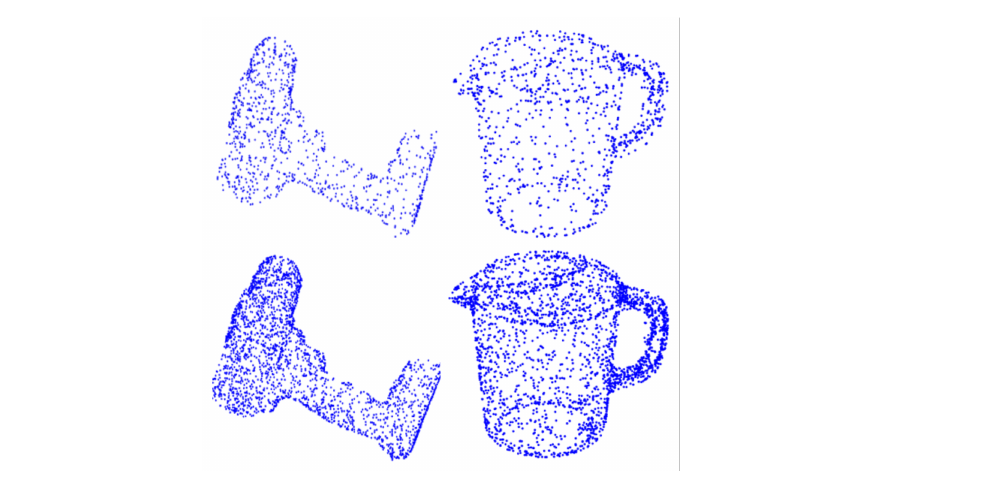
Figure 7. Point cloud of original dataset and adjusted image. The upper row is the model provided by the dataset, which is not highly identifiable. After adjusting the distribution of the template point cloud, a more accurate model can be